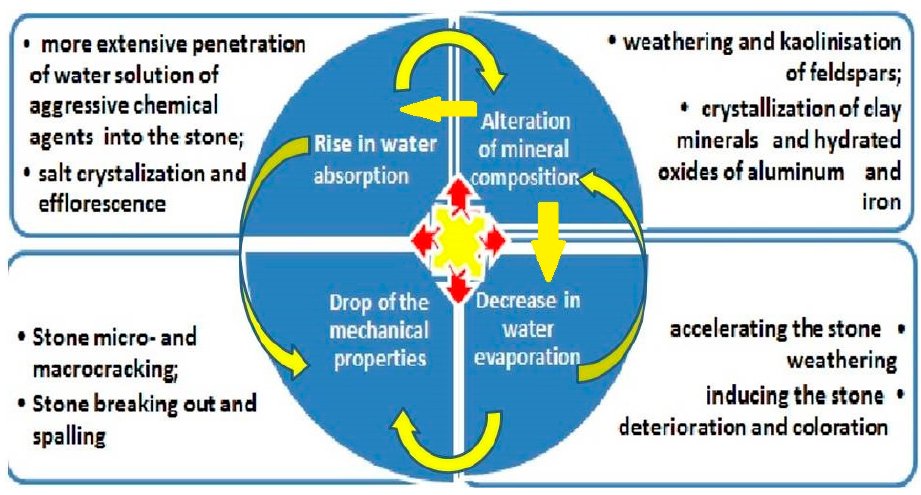
Figure 14. Diagram presenting the Interaction between the changes in the different stone properties.